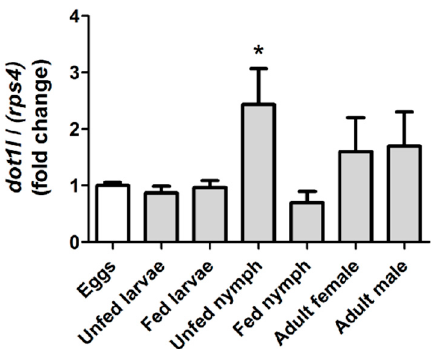
Figure 2. Relative expression of Omdot1l in different lifecycle stages of O. moubata . The relative expression of Omdot1l was determined using qPCR. Total RNA was extracted from eggs (white bar), unfed and fed larvae, unfed and fed first-stage nymphs and adult male and female O. moubata (grey bars). cDNA was synthesized and equal amounts of cDNA were used in a qPCR assay using rps4 as a normalizing gene. The expression of mRNA is relative to the expression of Omdot1l in the eggs. Unpaired t Test: * p < 0.05.